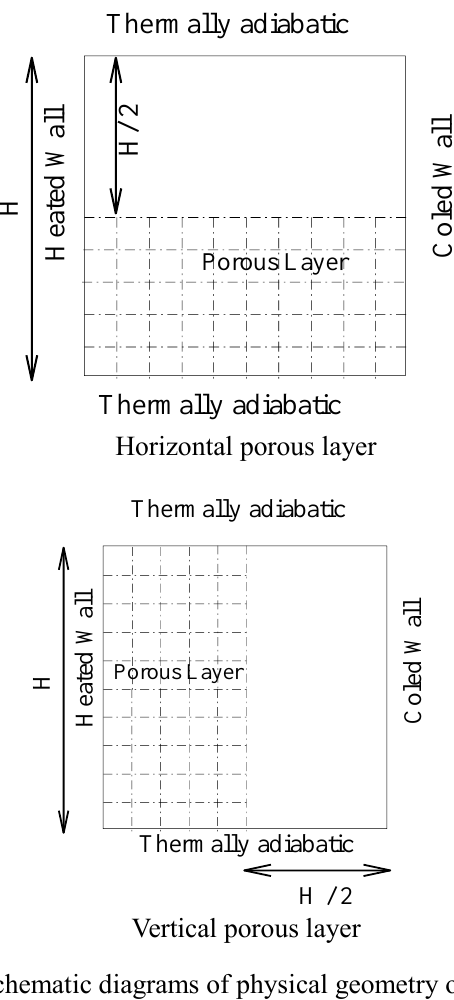
Fig. 1. Schematic diagrams of physical geometry of the